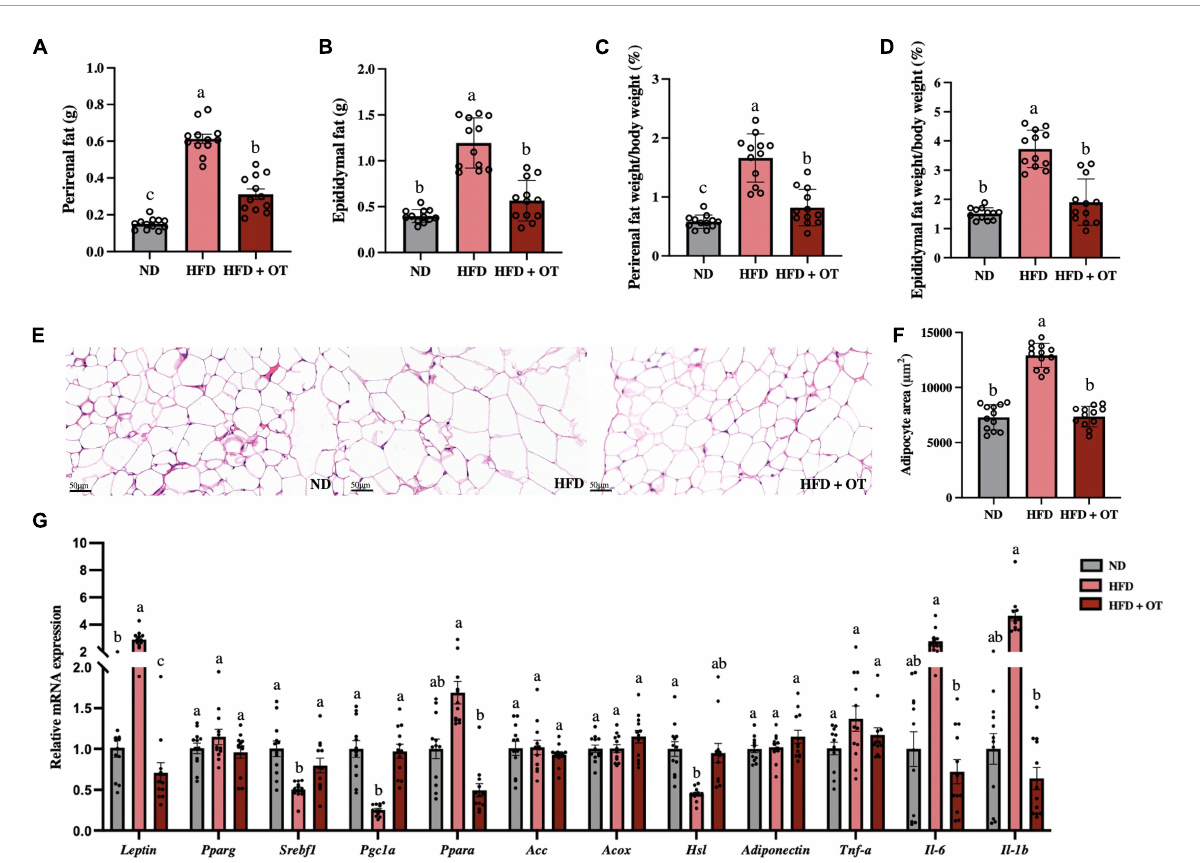
FIGURE2 Oolong tea alleviated HFD-induced hypertrophy of white adipose tissue and lipid metabolism disorder. (A) Perirenal fat weight. (B) Epididymal fat weight. (C) Perirenal fat/body weight ratio. (D) Epididymal fat/body weight ratio. (E) Representative images of histological sections of epididymis adipose (scale bar, 50 µ m). (F) Adipocyte area. (G) Relative expression of Leptin , Pparg1 , Srebp1c , Pgc1a , Ppara , Acc , Acox , Hsl , Adiponectin , Tnf- α , Il-6 , and Il-1b in the epididymal adipose tissue. Data are expressed as mean ± SEM ( n = 12). The mean value with different letters indicates significant differences ( p <